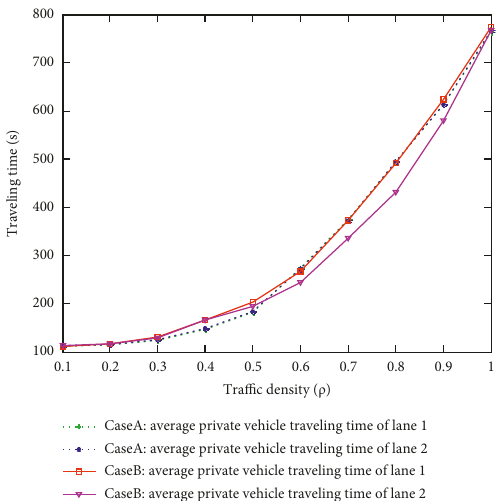
Figure 6: Average car travel time in Group A and Group B given traffic density.